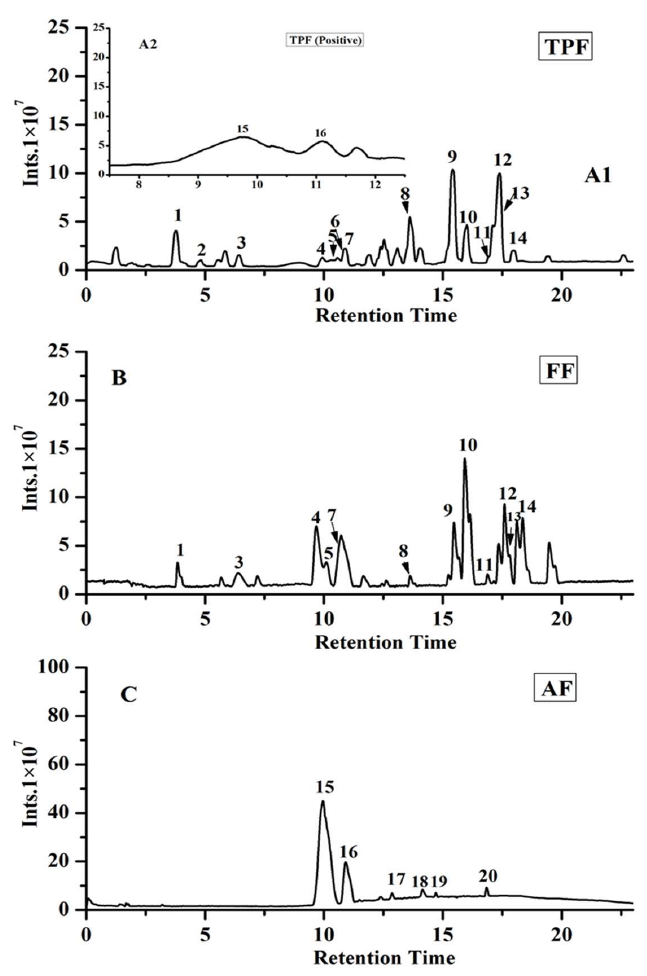
Figure 1. Negative ( A1 , B ) and positive ( A2 , C ) ion current chromatograms of different fractions from P. utilis fruits: total phenolic fraction ( A ), flavonoid-rich fraction ( B ), anthocyanin-rich fraction ( C ). The identification of peaks and their MS data are shown in Table 1.